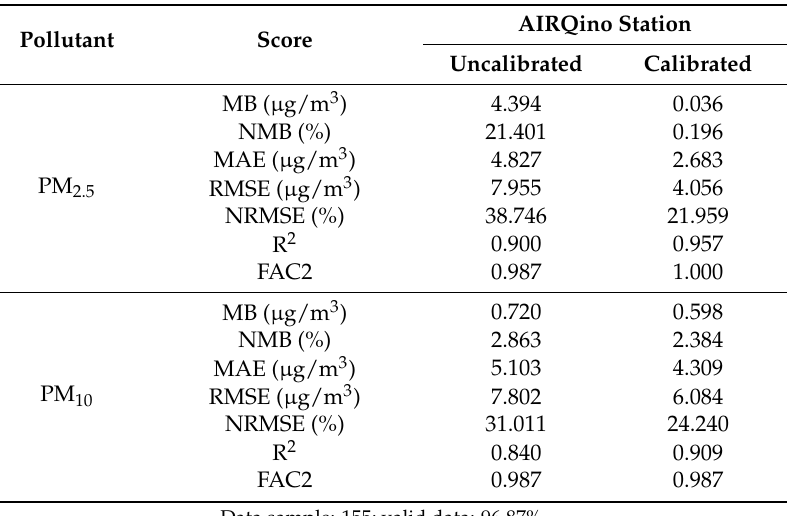
Table 6. Statistical scores of the comparison in measuring 24-h averaged PM 2.5 and PM 10